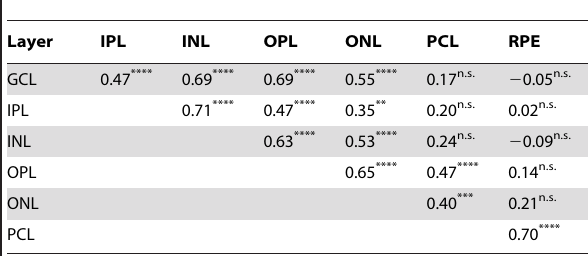
Table 1. Pearson’s correlation coefficients for retinal thickness among 115 Astyanax F 2